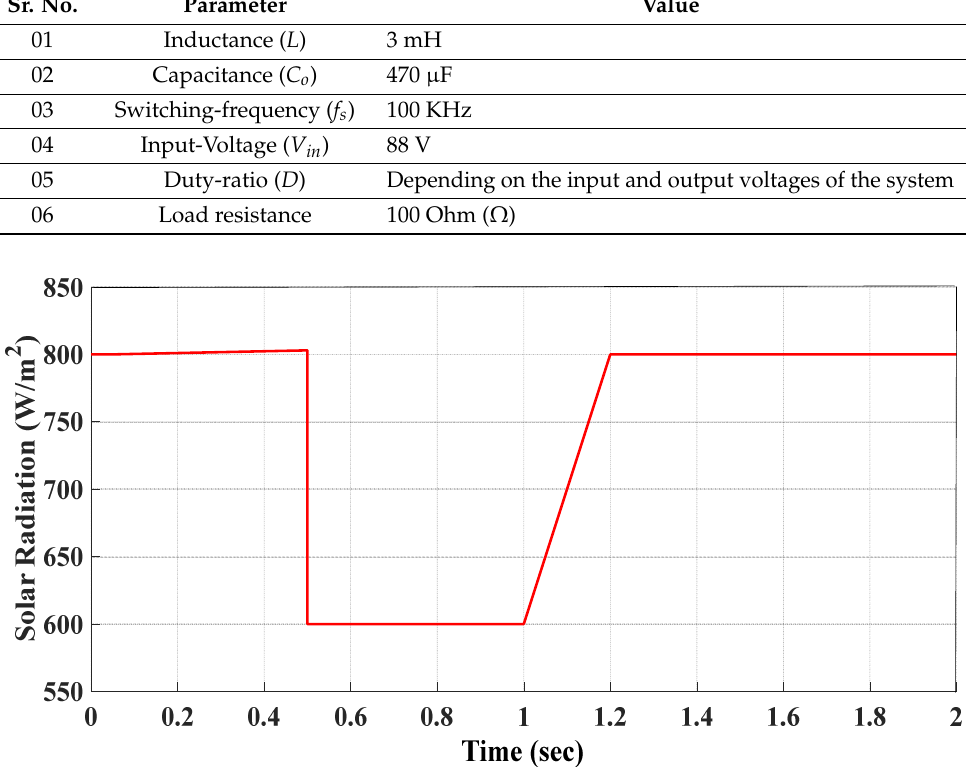
Table 3. WTIG Module Specifications.